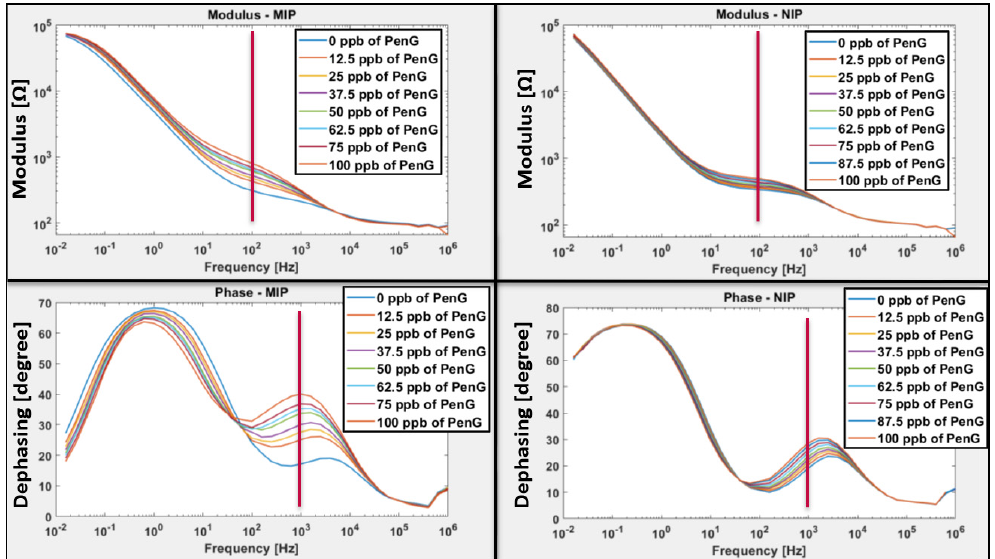
Figure 6. EIS modulus ( above ) and phase ( below ) graphs for MIP ( left ) and NIP ( right ) sensors while increasing the penicillin G concentration. Chosen frequencies are highlighted thanks to the red line.